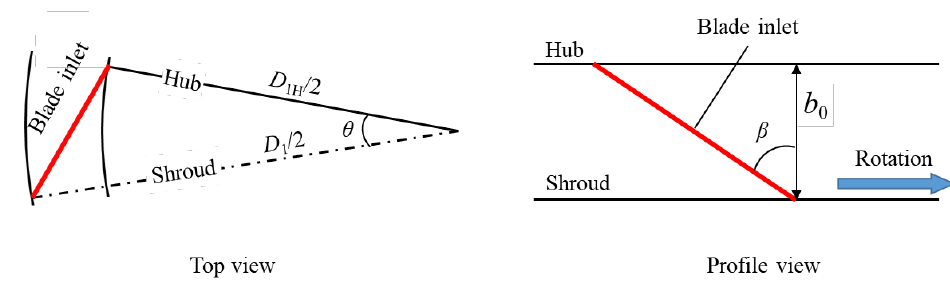
Figure 7. Schematic of blade lean at inlet edge.